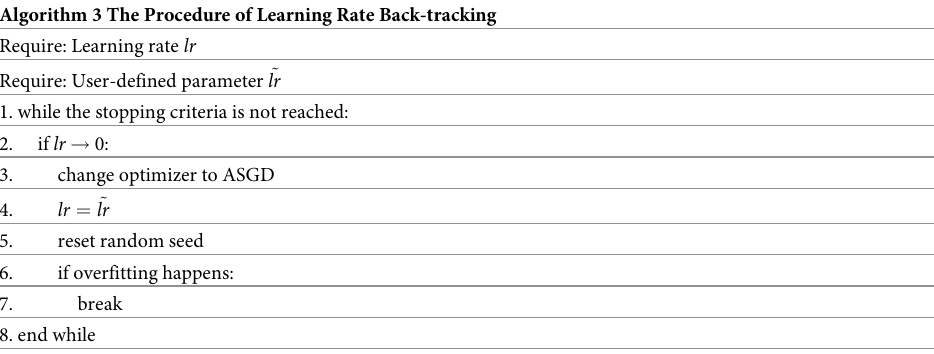
Table 6. The pseudocode of the learning rate back-tracking. Algorithm 3 The Procedure of Learning Rate